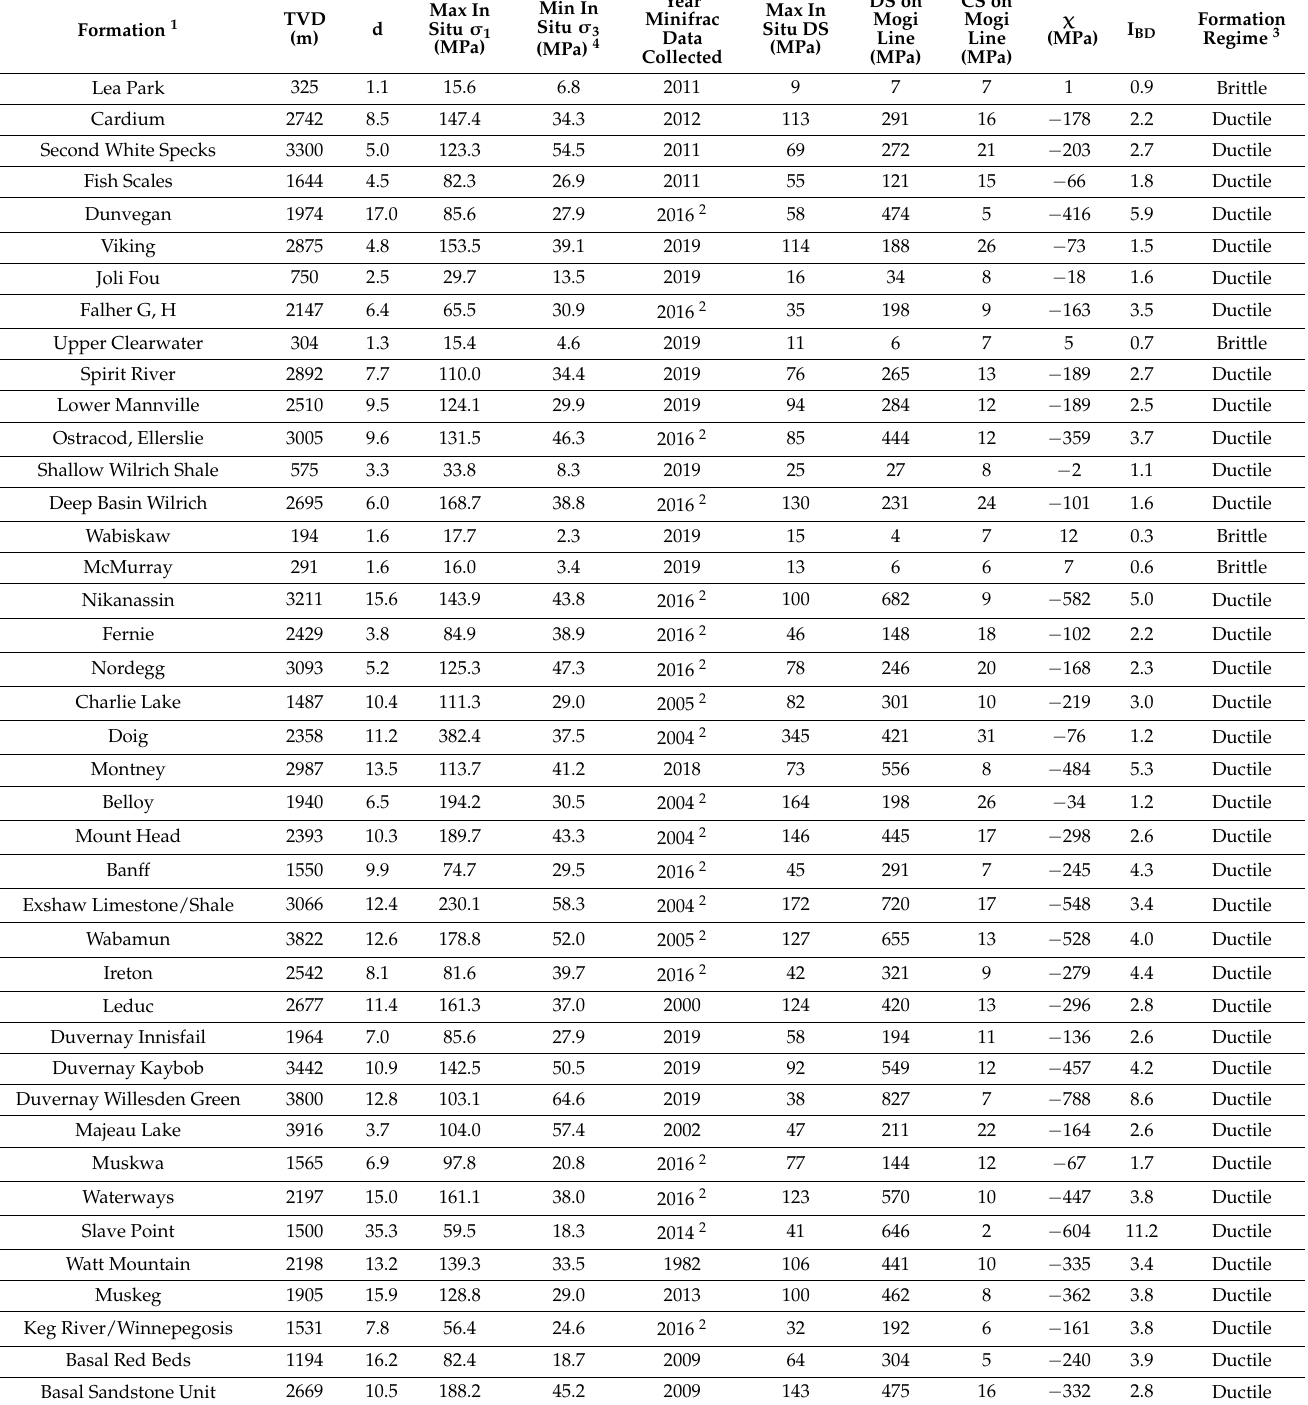
Table 4. Assessment of the Brittle–Ductile State ( χ ) and Brittle–Ductile Stress Index (I BD ) of major formations in the Alberta Basin (at the time of in situ stress and pore pressure data measurements and under the LCS-HDS